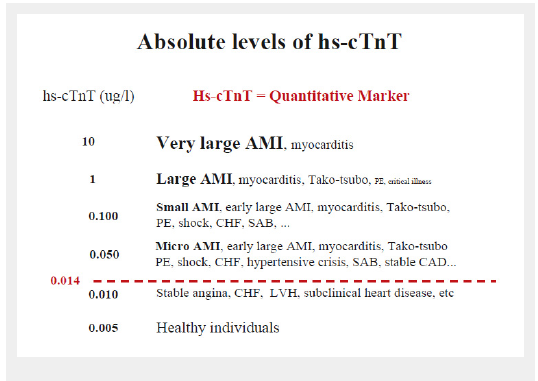
The differential diagnosis of high-sensitive cardiac troponin T (hs- cTnT) levels is highly dependent on the absolute